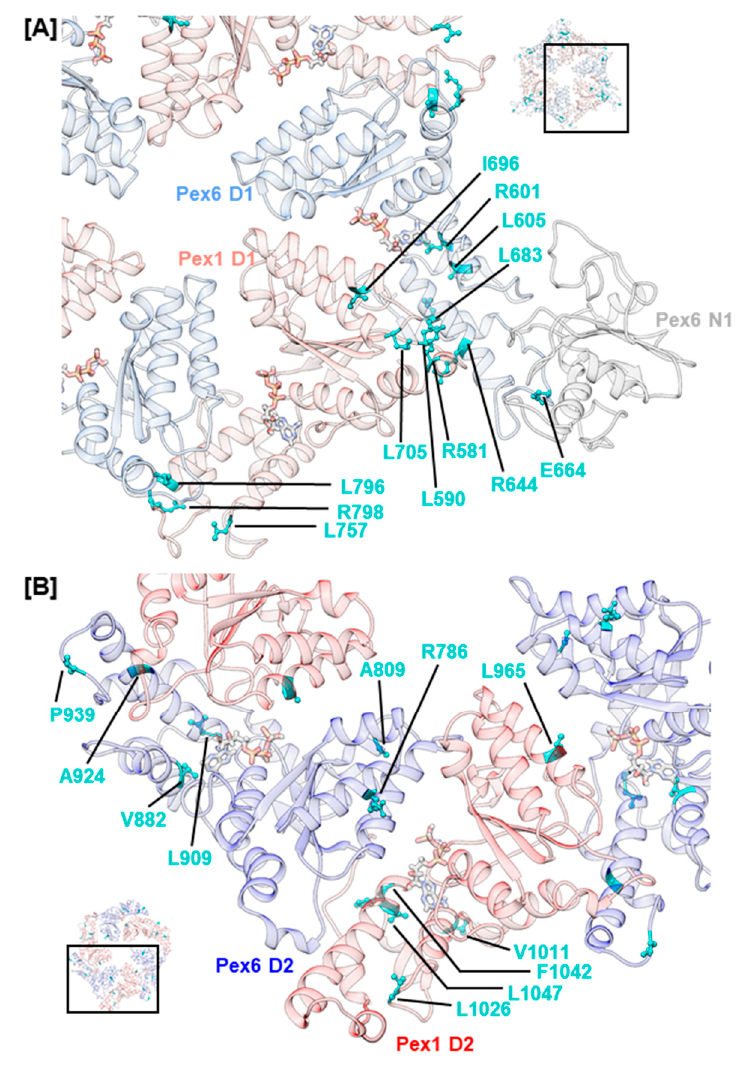
Figure 5. Structural mapping of mutations that concern the interaction between Pex1 and Pex6 in the D1 ring ( A ) and the D2 ring ( B ). Concerned amino acids and ATP are shown as sticks. Insets show the D1 ring and D2 ring as top views with selection of the enlarged area.